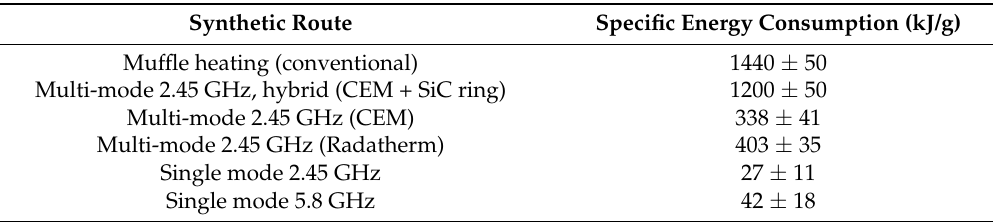
Table 3. Calculated specific energy consumption depending on the synthetic route and equipment used.